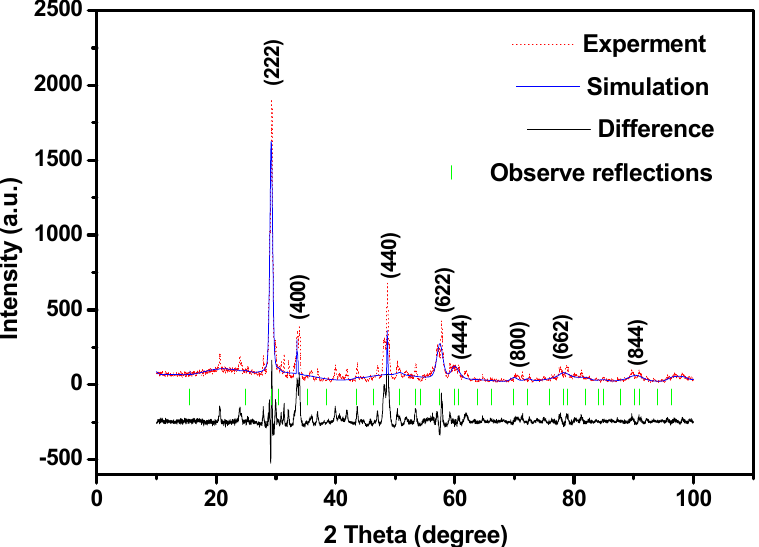
Figure 1. X − ray powder diffraction (XRD) patterns and Rietveld refinements of Y 2 SmSbO 7 (red dotted line represents experimental XRD data of Y 2 SmSbO 7 ; blue solid line represents simulated XRD data of Y 2 SmSbO 7 ; black solid line represents the difference between experimental and simulated XRD data of Y 2 SmSbO 7 ; green vertical line represents observed reflection positions). Table 1. Structural parameters of Y 2 SmSbO 7 prepared by solid reaction process.